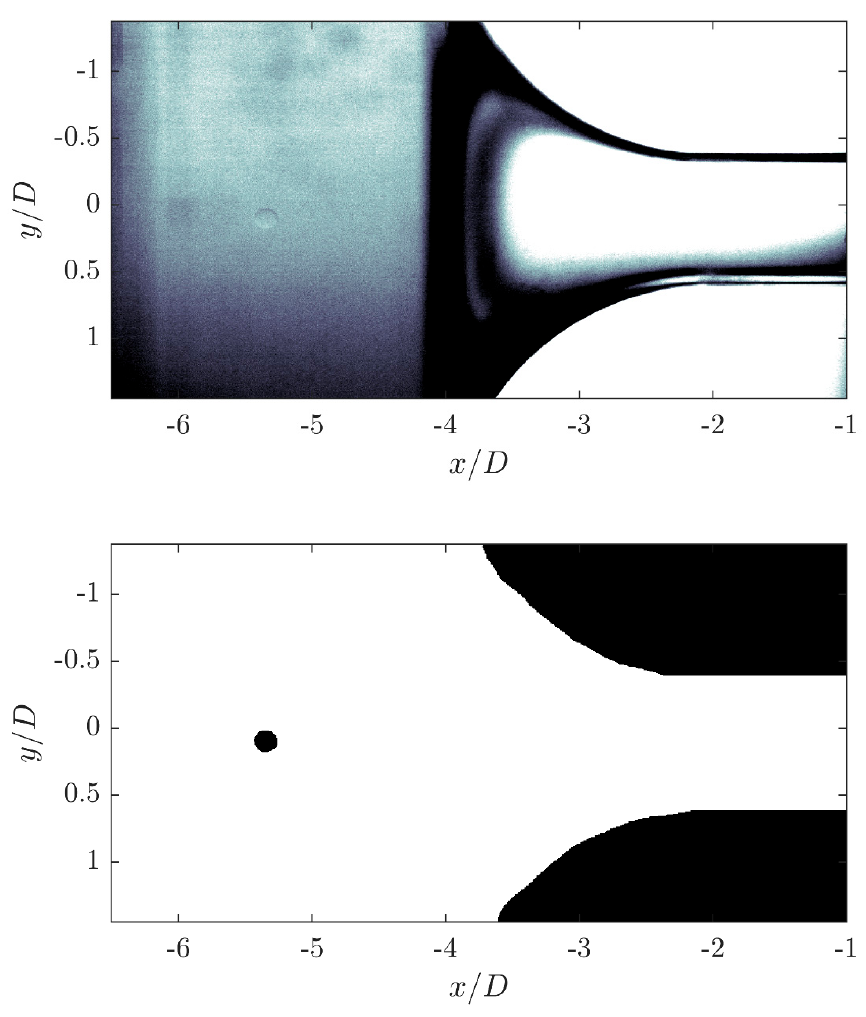
Figure 5. Comparison of the original image and the binarized image of a droplet flowing into the orifice.